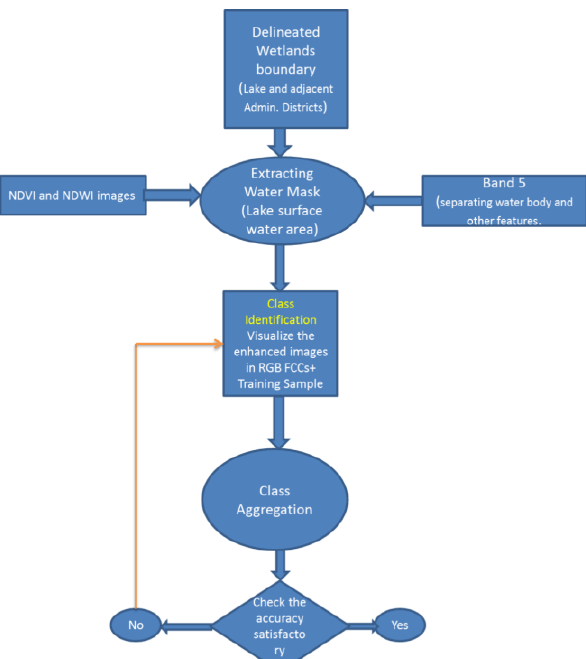
Figure (3) Flow chart of classification process